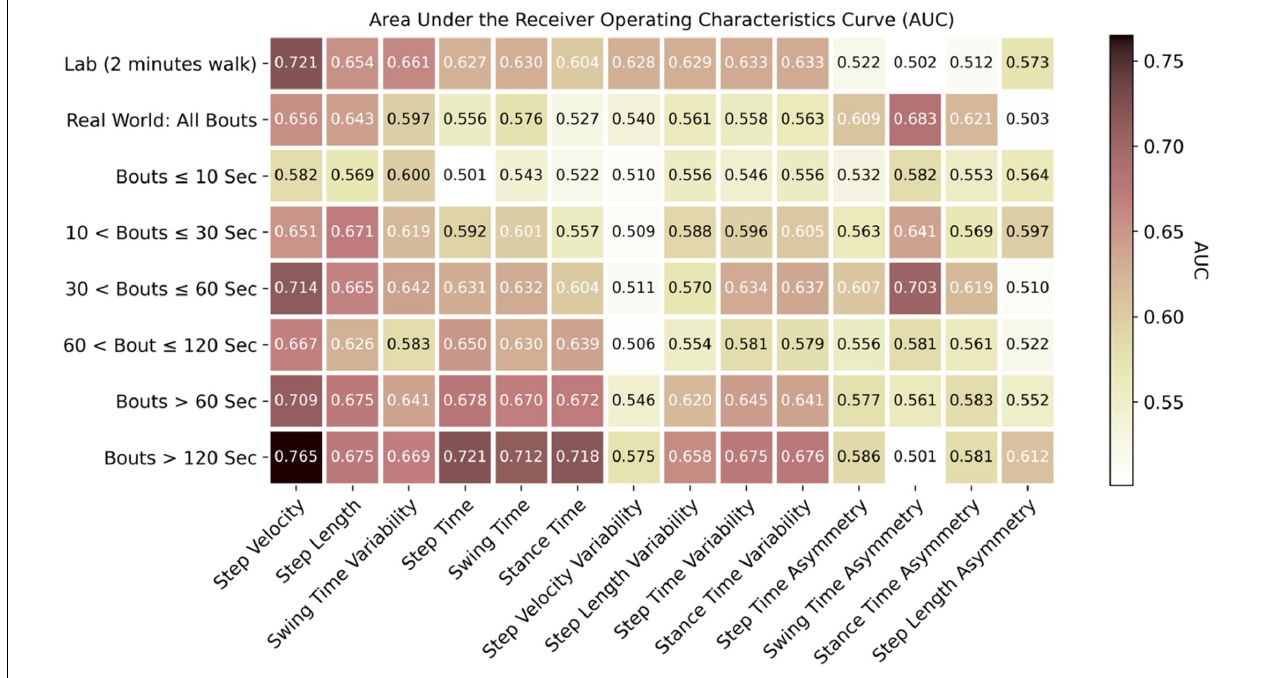
FIGURE 6 | Discrimination of PD from HC based on each individual gait characteristic with area under the receiver operating characteristics curve (AUC).